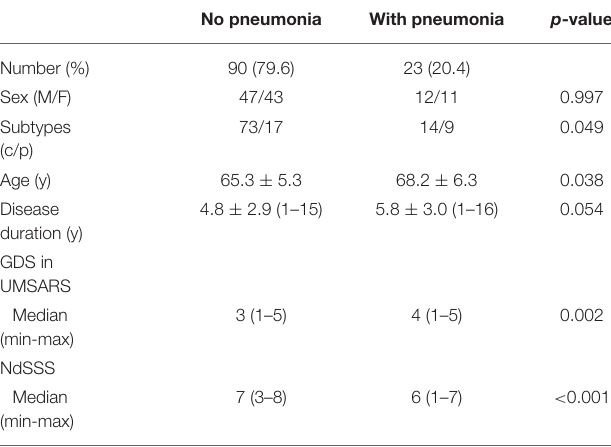
TABLE 7 | Binomial logistic regression analysis of factors related to a history of pneumonia in patients with multiple system atrophy. Factors